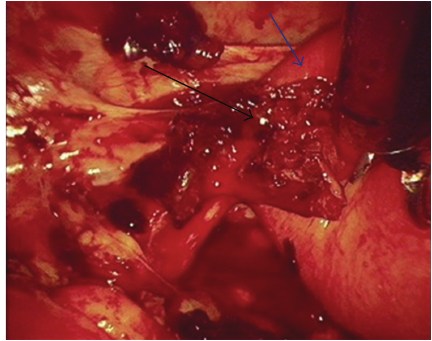
Figure 2: Ruptured ectopic pregnancy (black arrow) in remnant of left tube (blue